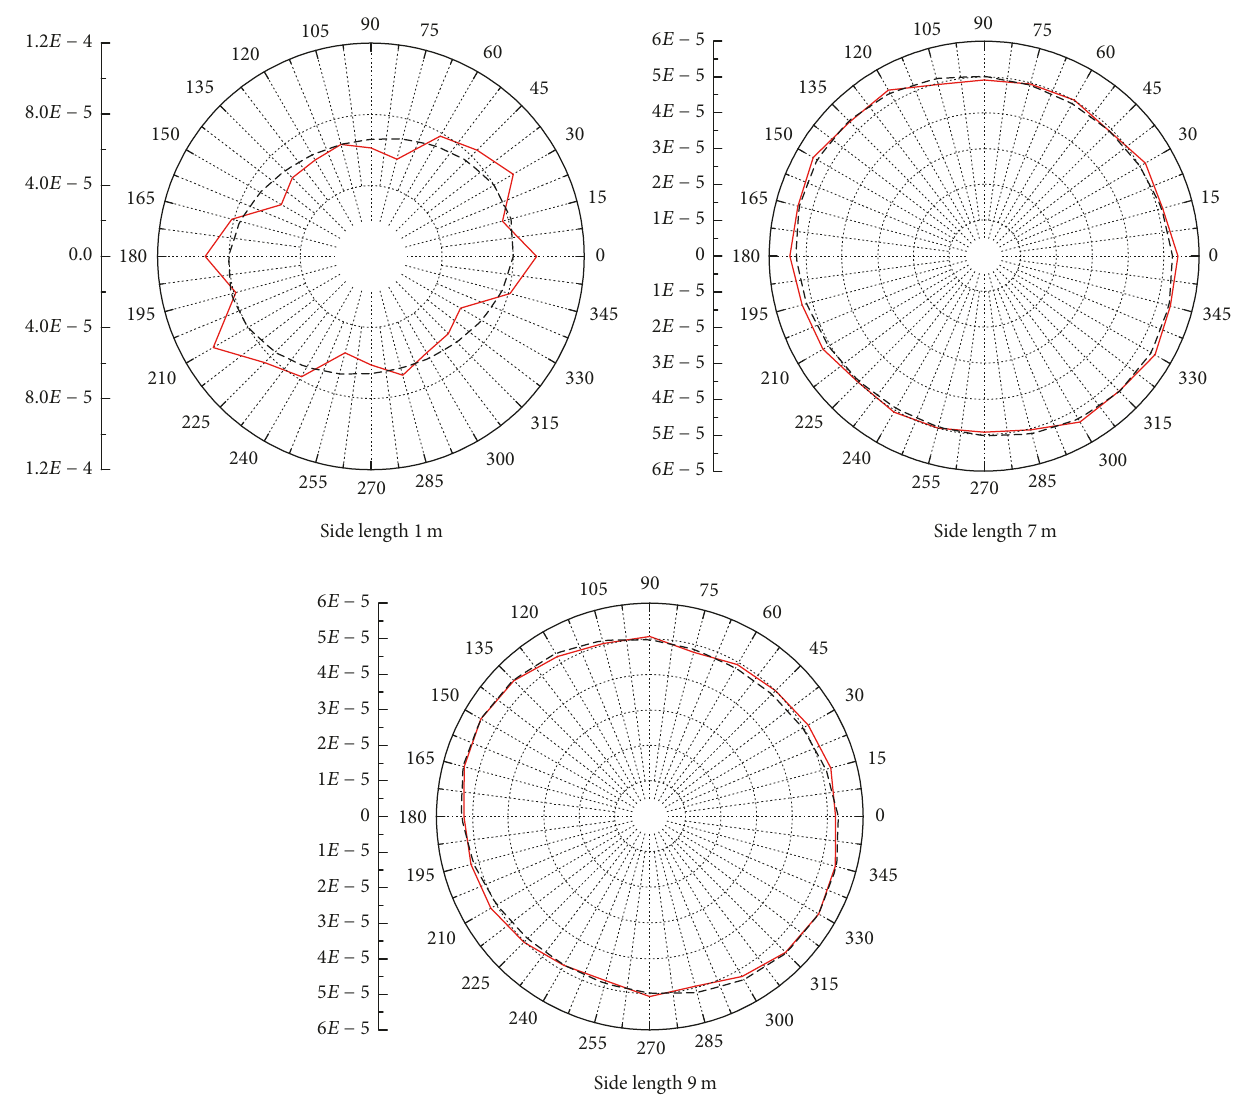
Figure 29: The equivalent non-Darcy coefficient ellipse with the increasing model size in the non-Darcy